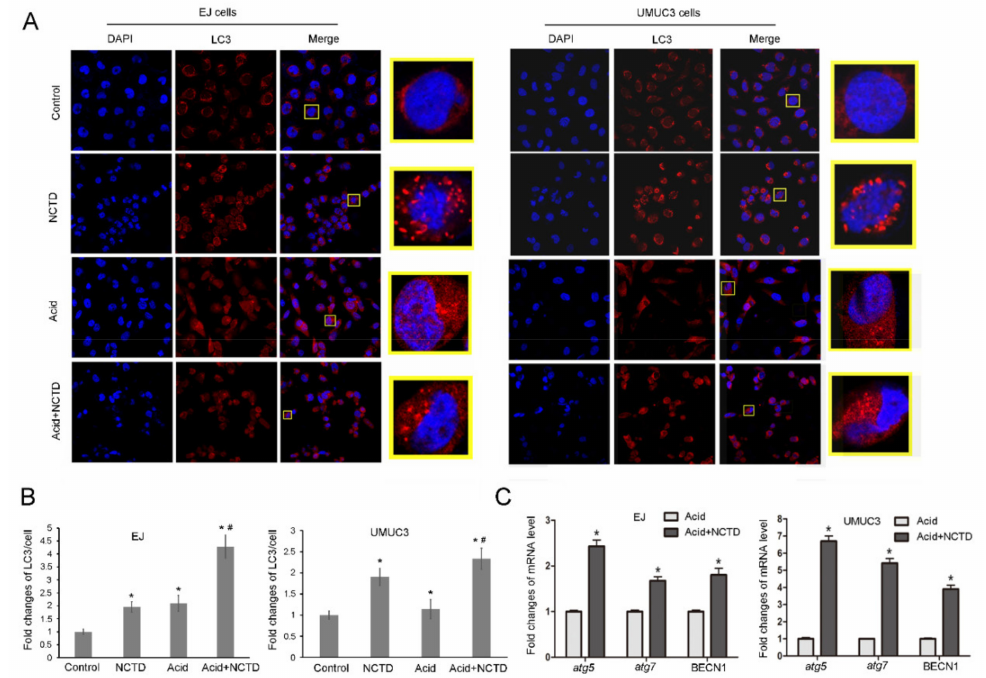
Figure 5. NCTD further enhances autophagy in acidic culture. EJ and UMUC3 cells were treated with NCTD under physiological pH or in an acidic medium for 24 h, ( A ) autophagosomes were detected by using immunostaining with LC3 antibody and observed under fluorescence microscope (400 × ). ( B ) the relative LC3 puncta/cells were presented as fold changes. * p < 0.05 vs. the control group; # p < 0.05 vs. the acidic group. ( C ) mRNA levels of atg5, atg7, and BECN1 were detected by Real-time PCR. Data are presented as the mean ± SD ( n = 3), * p < 0.05 vs. the Acid